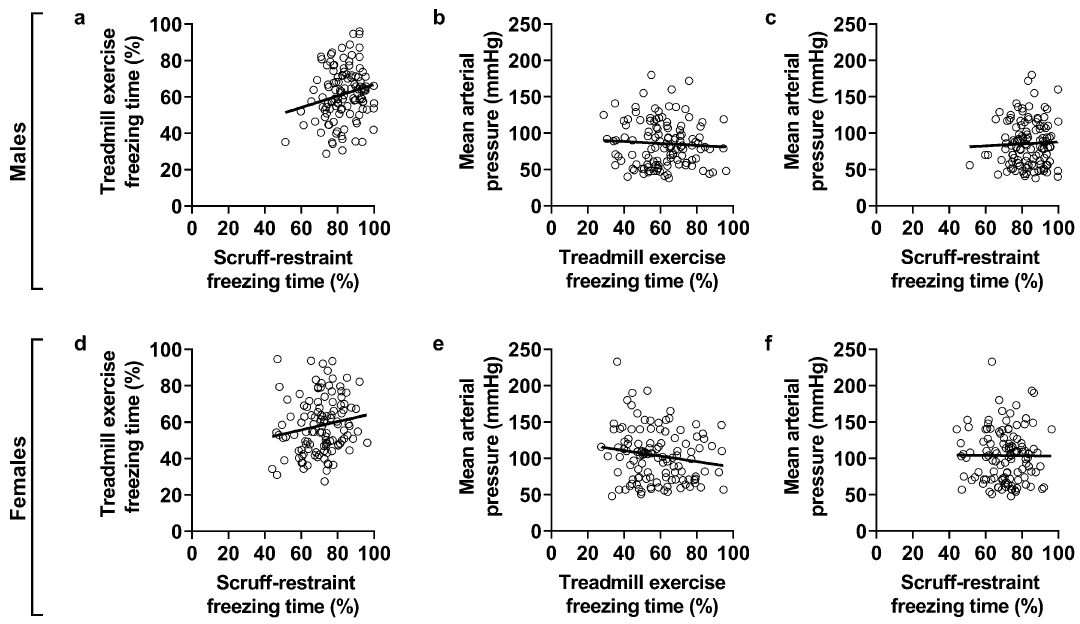
Figure 3. Idiosyncratic response of mdx mice to various stressors. ( a ) Relationship between freezing time (%) after treadmill exercise and scruff-restraint in male ( mdx -hemi) and ( d ) female ( mdx -homo) mdx mice. ( b ) Relationship between mean arterial pressure (MAP) during a plexiglass-restraint stress and freezing time (%) after treadmill exercise in male ( mdx -hemi) and ( e ) female ( mdx -homo) mdx mice. ( c ) Relationship between MAP during a plexiglass-restraint stress and freezing time (%) after scruff-restraint in male ( mdx -hemi) and ( f ) female ( mdx -homo) mdx mice. Mdx -hemi (n = 119) and mdx -homo (n = 117). Data were analysed by linear